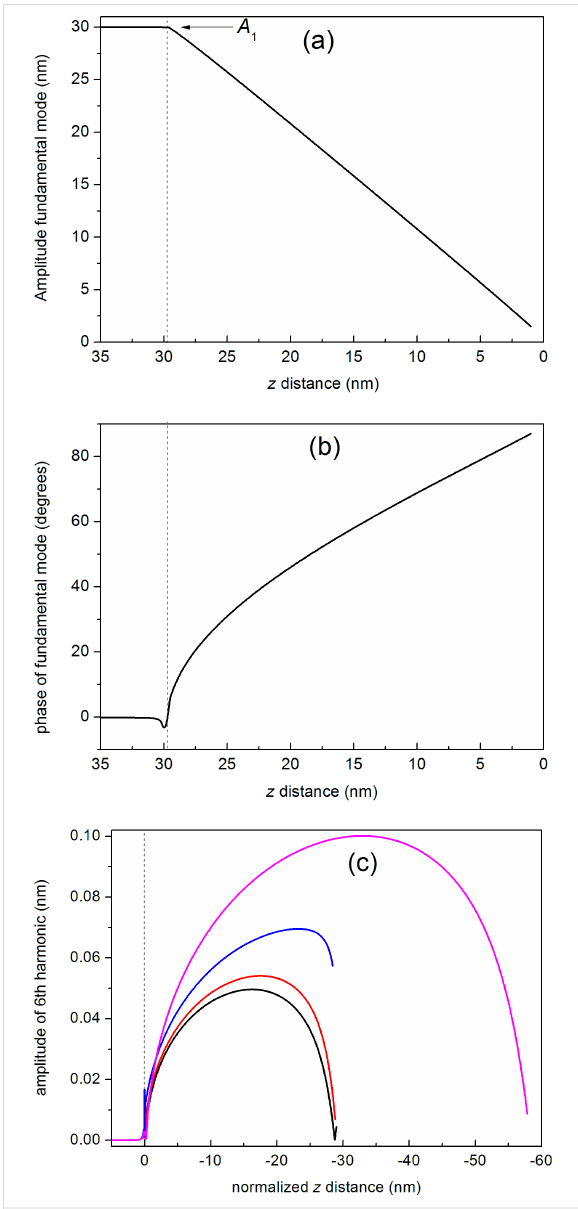
Figure 1: (color online) Simulated approach curves: (a) amplitude of the fundamental mode, (b) phase of the fundamental mode and (c) amplitude of the 6th mode as a function of the normalized z dis- tance. The calculations have been performed for a silicon rectangular cantilever with k c = 25 N/m, f 0 = 300 kHz and Q = 400. The following parameters have been used: (a) and (b) A 1 = 30 nm, R = 10 nm, E = 3 GPa, (c) continuous black curve A 1 = 30 nm, R = 10 nm, E = 3 GPa; continuous red curve A 1 = 30 nm, R = 30 nm, E = 3 GPa; continuous blue curve A 1 = 30 nm, R = 10 nm, E = 130 GPa; continu- ous magenta curve A 1 = 60 nm, R = 10 nm, E = 3 GPa.